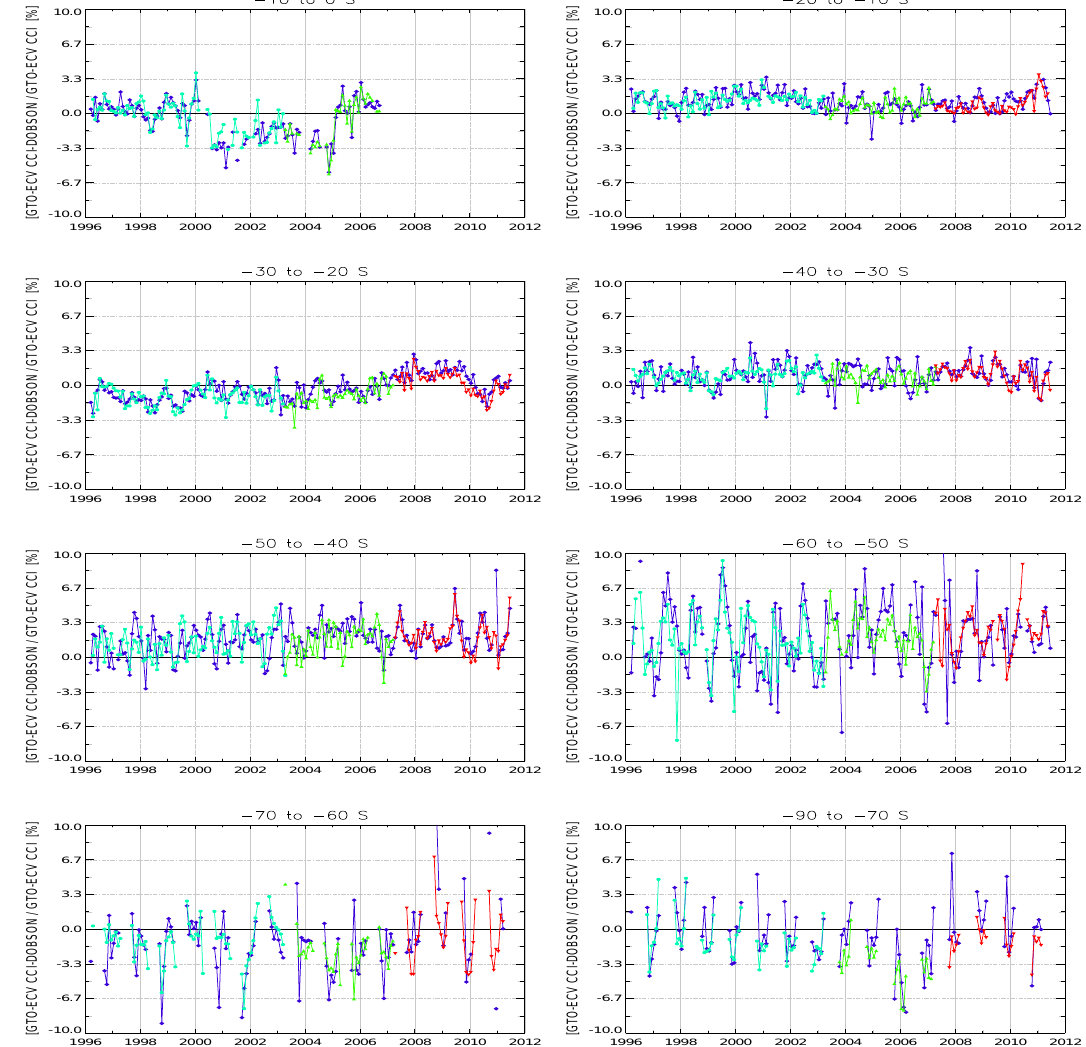
Figure 11. Percentage difference between satellite data records and Dobson ground-based data as a function of time for the Southern Hemisphere for seven 10 ◦ zonal belts from 0–70 ◦ S and one belt from 70–90 ◦ S. Level 3 comparison in dark blue, GOME level 2 comparison in light blue, SCIAMACHY in green, and GOME-2A in